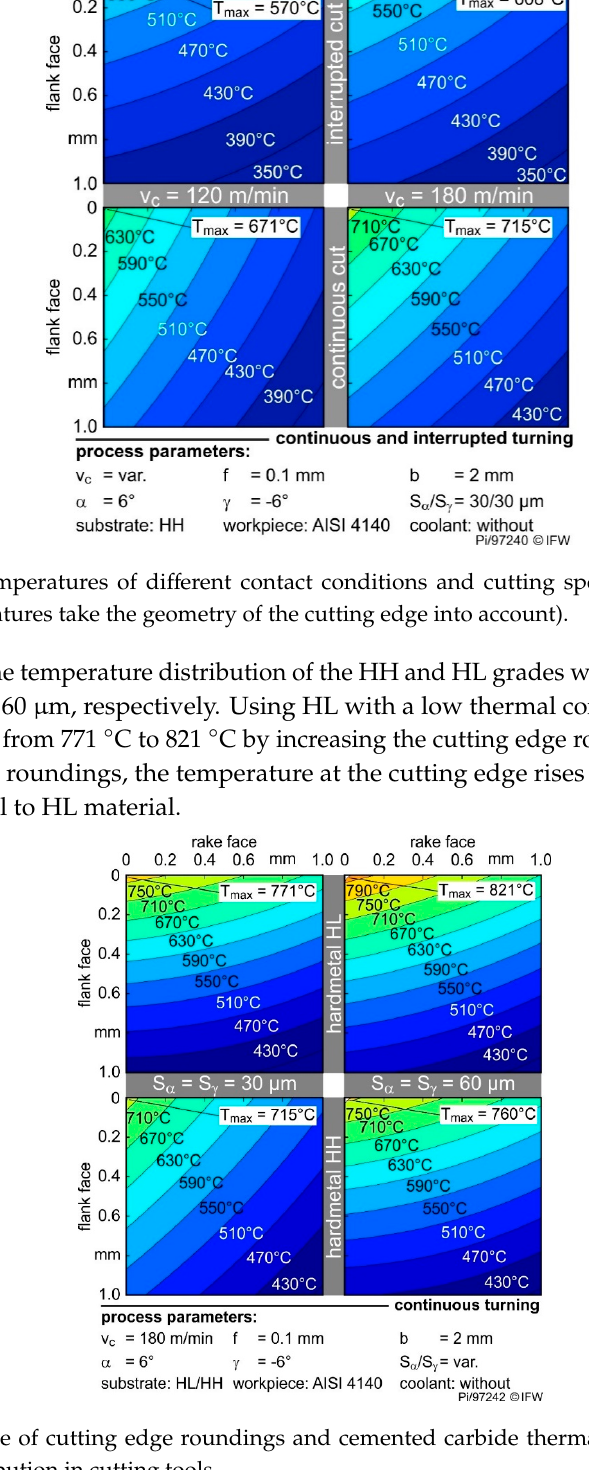
Figure 8. Comparison of the temperature distribution of the used cemented carbides.